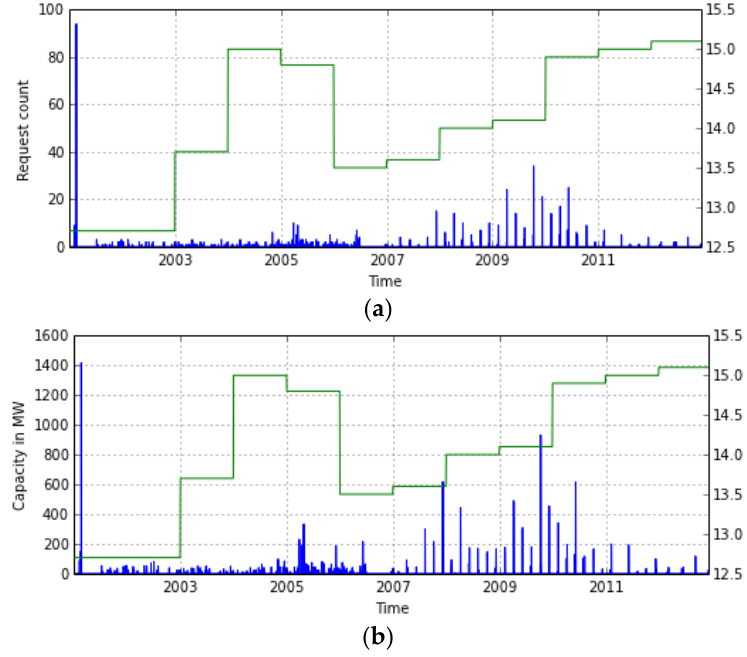
Figure 2. Evolution of demand and PI for interconnected wind RES ‐ E investments. ( a ) Number of operation license requests for interconnected onshore wind RES ‐ E during January 2001 to December 2012; and ( b ) capacity that corresponds to the operation license requests for interconnected onshore wind RES ‐ E during January 2001 to December 2012.